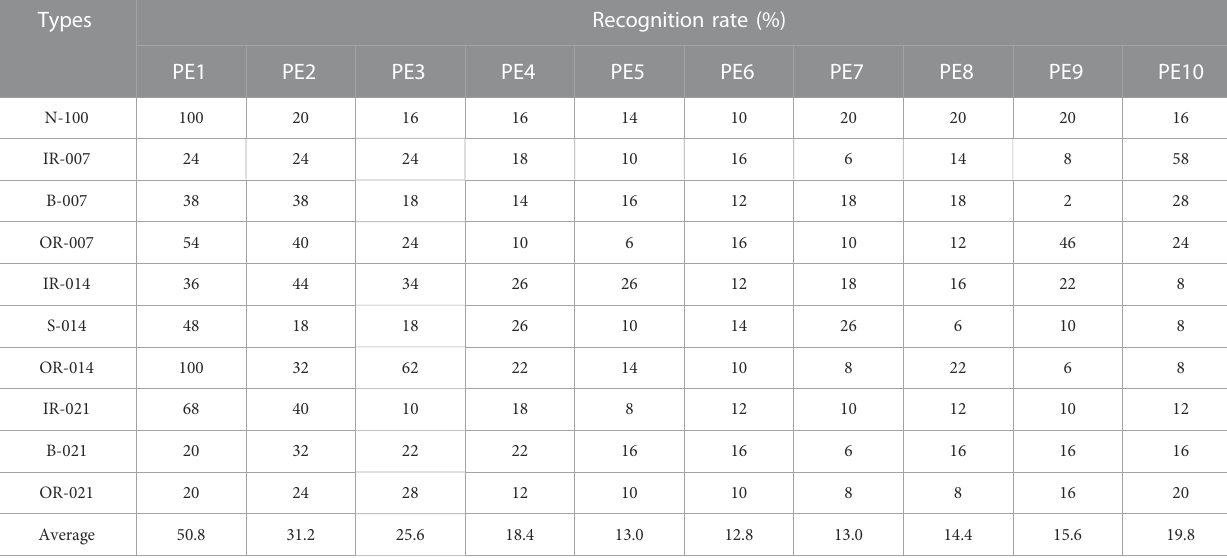
TABLE 2 Single feature recognition results for ten scales of MPE for ten types of signals.